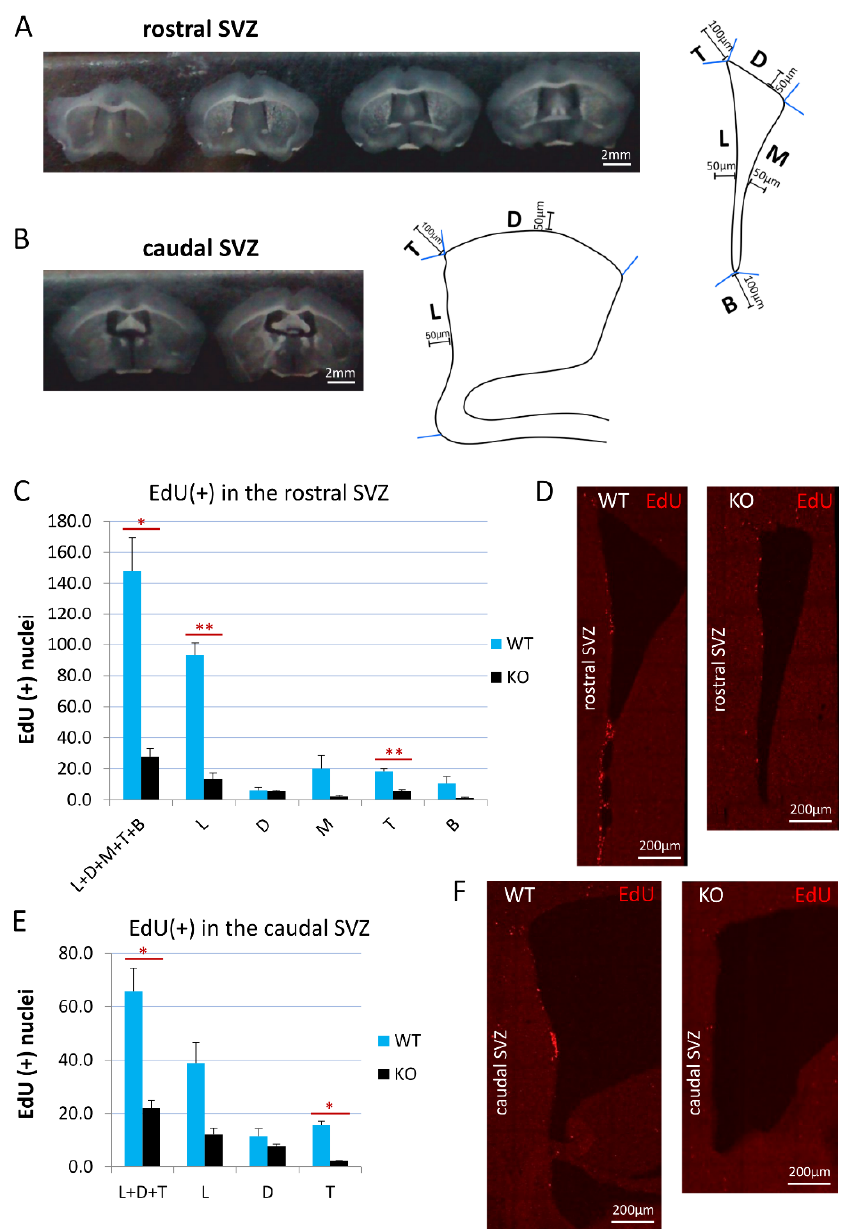
Figure 1. Cyclin D2 KO mice present significantly reduced proliferation activity in the SVZ. ( A , B ) Coronal sections of the ( A ) rostral and ( B ) caudal compartments of the subventricular zones along anterior–posterior brain axis, and schemes of the ( A ) rostral, and ( B ) caudal SVZ compartments. The distances of 100 µ m and 50 µ m demarcate the thicknesses of the SVZ region taken for quantitative analyses of cell numbers. ( C , E ) Cyclin-D2-deficient mice show significantly reduced numbers of proliferating cells [(EdU(+) nuclei] in the whole SVZ—subregions: L+D+M+T+B ( p = 0.024) in the ( C ) rostral compartment, and L+D+T ( p = 0.0266) in the ( E ) caudal compartment, compared to WT mice. In detailed analyses, cD2-KO mice show reduced numbers in the lateral wall (L, p = 0.0036) and the top cone (T; p = 0.0023) in the ( C , D ) rostral part, and in the top cone (T, p = 0.0121) of the ( E , F ) caudal SVZ, compared to WT mice. There were no significant differences in the other subregions: in the rostral SVZ (the D, p = 0.7755; the M, p = 0.1721; the B, p = 0.1724), and in the caudal SVZ (L, p = 0.0626; D, p = 0.3053). Abbreviations: L—the lateral wall; D—the dorsal wall; M—the medial wall; T—the top cone; B—the bottom cone. Data are shown as mean ± SD (* p ≤ 0.05, ** p ≤ 0.01).